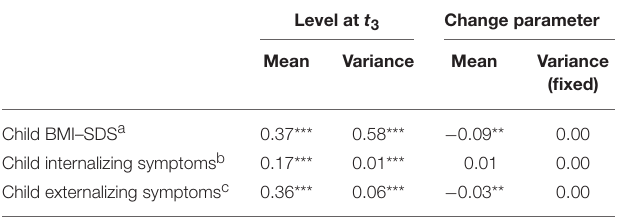
TABLE 3 | Means (unstandardized) and variances of the level at t 3 and change parameter for children’s BMI–SDS and internalizing and externalizing